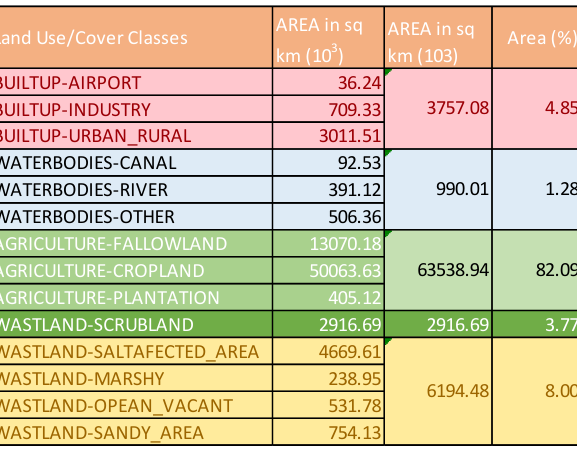
Table 1. Statistics of different LULC classes for